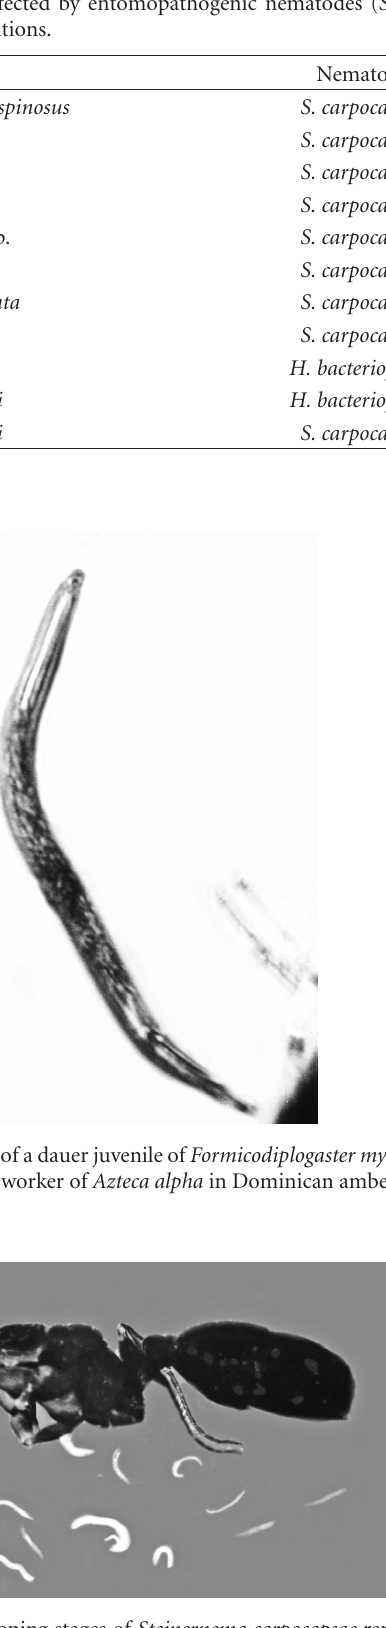
Figure 25: Developing stages of Steinernema carpocapsae removed from the body of an infected queen of Solenopsis invicta